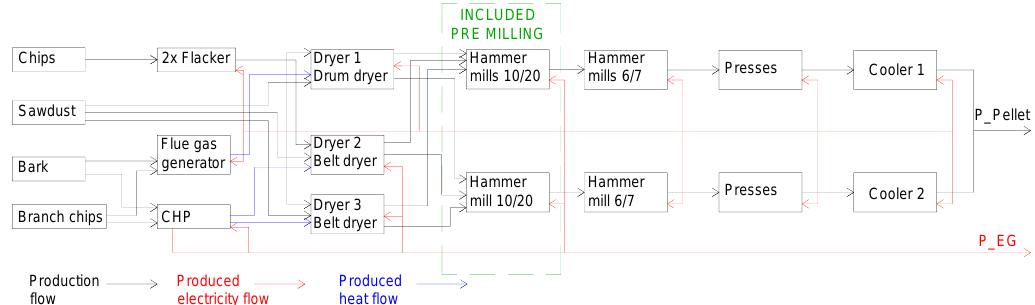
Fig. 4. Modified operational scheme of the pellet production facility with